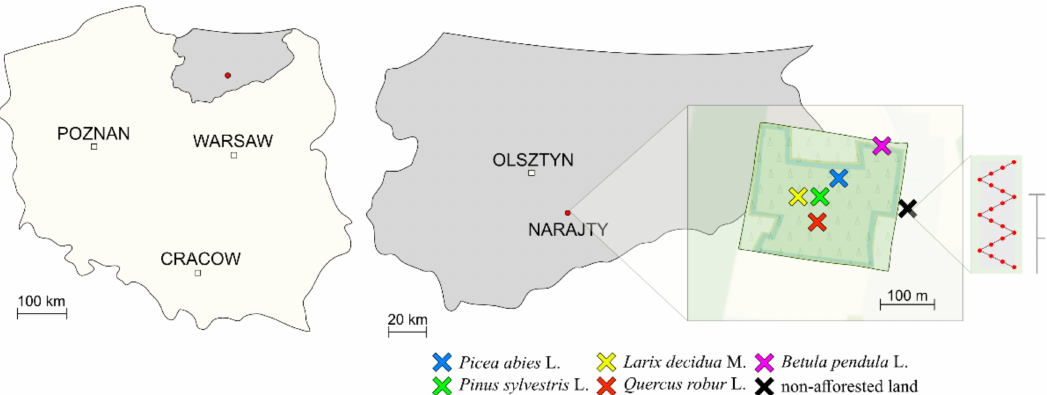
Figure 1. A map of the soil sampling sites. The Narajty in the Pasym commune (53°36 ′ 00.8 ″ N 20°47 ′ 25.1 ″ E) of the Warmian – Masurian Voivodeship (Poland). — 15,900 seedlings of English oak ( Quercus robur L. – Qr) planted on the area of 1.95 ha; — 4500 seedlings of Norway spruce ( Picea abies L. — Pa) planted on the area of 0.97 ha; — 7700 seedlings of Scots pine ( Pinus sylvestris L. — Ps) planted on the area of 0.97 ha; — 700 seedlings of European larch ( Larix decidua M. — Ld) planted on the area of 0.43 ha; — 2400 seedlings of warty birch ( Betula pendula L. — Bp) planted on the area of 0.55 ha; and — non-afforested land. — a soil sampling scheme with the use of Egners Riehm ’ s staff.